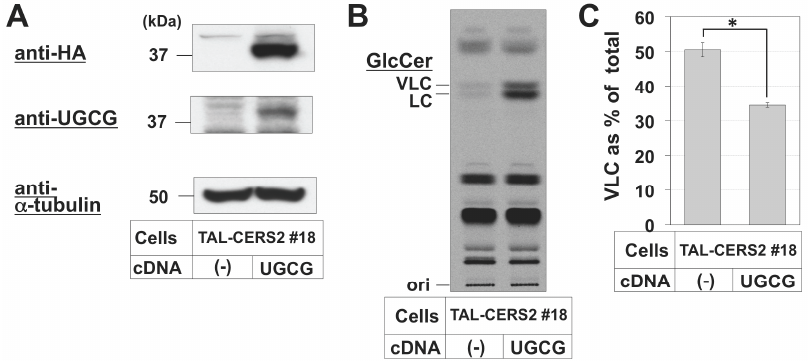
Figure 6. Effect of UGCG overexpression on the proportion of VLC in GlcCer. ( A ) Western blot analysis of UGCG in UGCG-overexpressed TAL-CERS2#18 cells. Cell lysates from TAL-CERS2#18 cells and UGCG-overexpressed TAL-CERS2#18 cells were immunoblotted with anti-HA antibody (HA), anti-UGCG antibody ( top ), and anti- α -tubulin antibody ( bottom ). 18, TAL-CERS2#18 clone; UGCG, UGCG overexpression. The whole images are shown in Figure S8. (-), no transfection; UGCG, UGCG cDNA overexpression; ( B ) metabolic labeling of sphingolipids with radioactive serine in TAL-CERS2#18 and UGCG-overexpressed TAL-CERS2#18 cells. Cells were cultured with [ 14 C]serine for 2 h, and lipids extracted from the cells were separated by Method 1 for GlcCer; ( C ) comparison of the proportions of VLC-GlcCer between endogenous GlcCer in TAL-CERS2#18 cells and overexpressed GlcCer in UGCG-overexpressed TAL-CERS2#18 cells. The proportions of VLC-containing GlcCer are expressed as described in Figure 2B: mean percentage ± SD obtained from three independent experiments. The Student’s t -test was used. * p < 0.05.